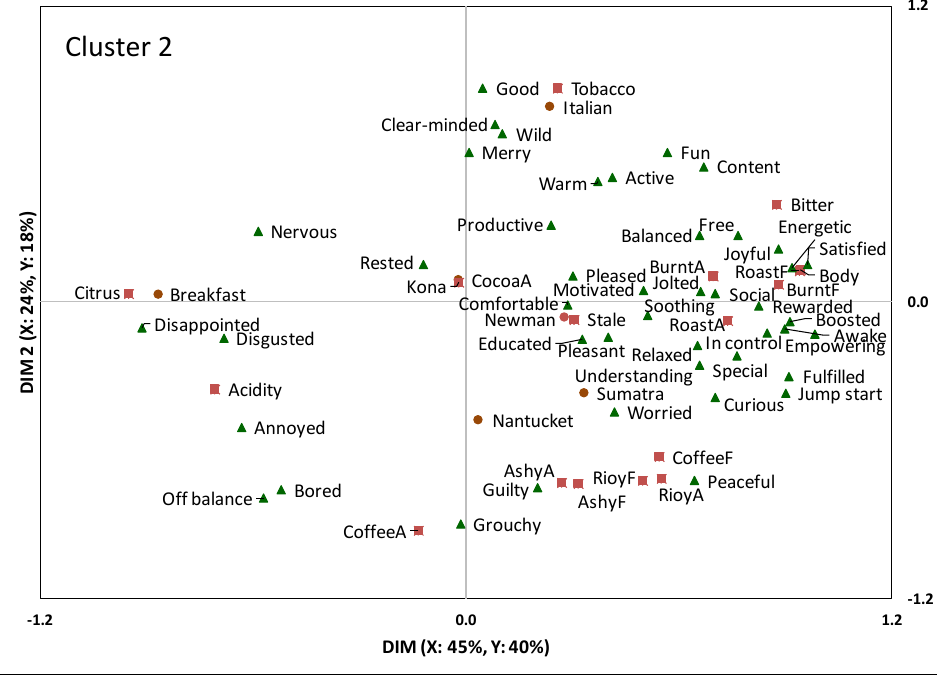
Figure 4. Partial least square regression analysis of descriptive sensory and CDE emotion lexicon of the six coffee samples for consumer Cluster 2.